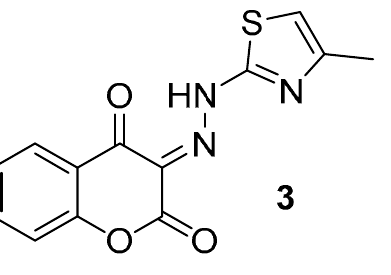
Figure 1. Chemical structure of ( E )-3-(2-(4-methylthiazol-2-yl)hydrazineylidene)chromane-2,4- dione ( 3 ).